Question: Which visualization type does this figure use?
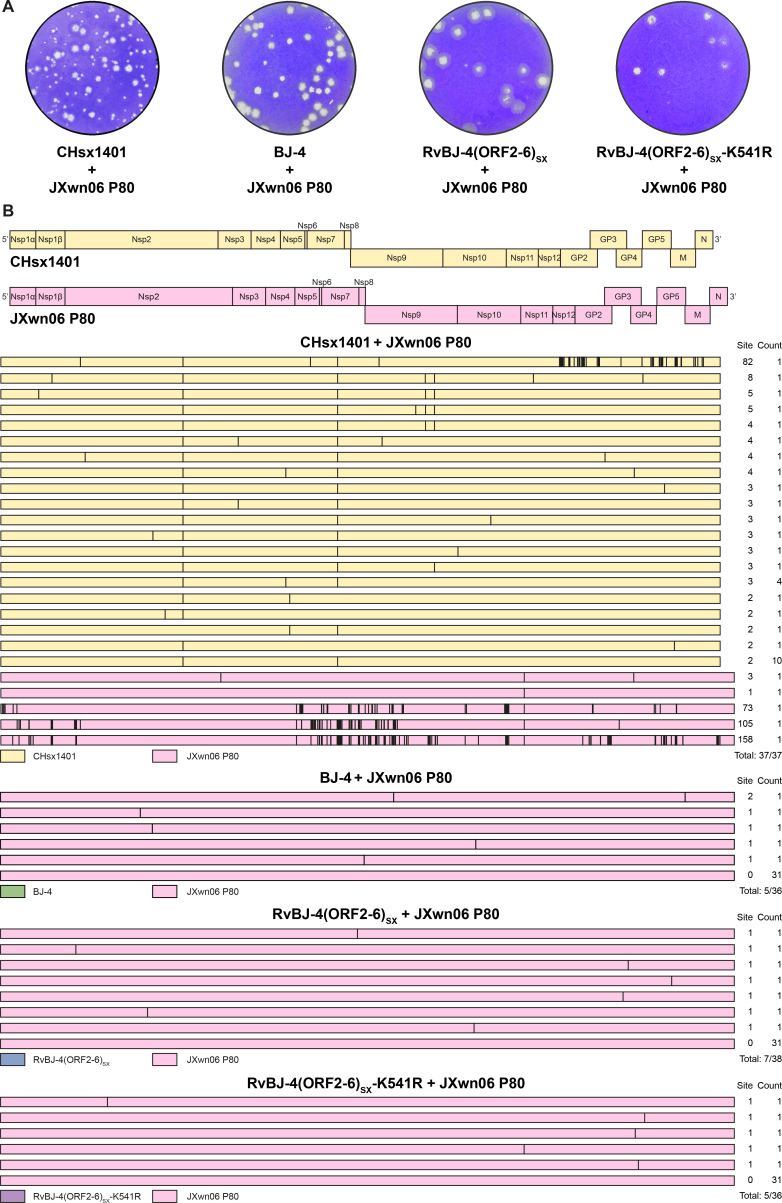
Answer: line